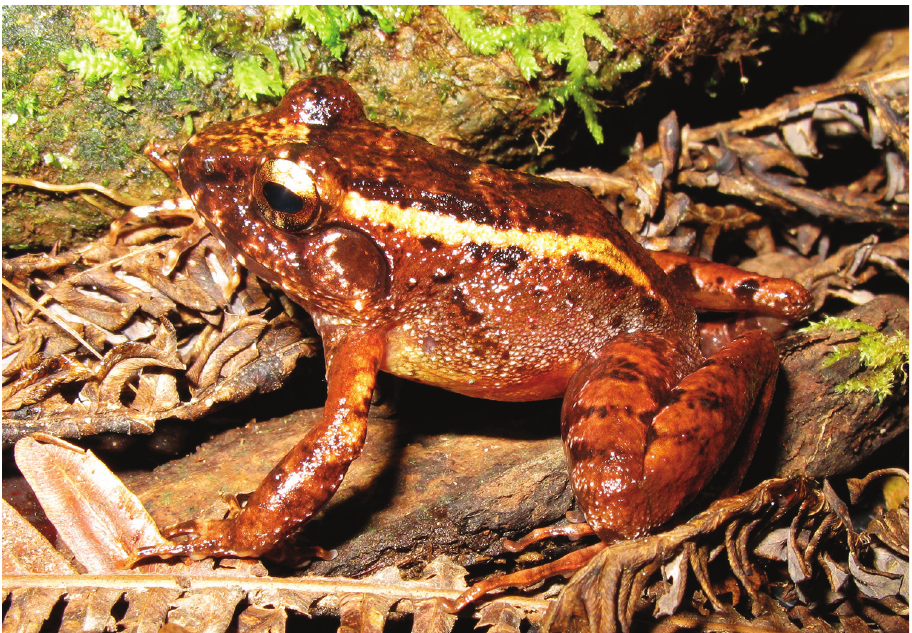
Figure 10. Platymantis sp. “Cliff-loud” male (specimen not collected) from Mt. Balatukan, Municipality of Gingoog, Misamis Oriental Province. Photo: ACD.